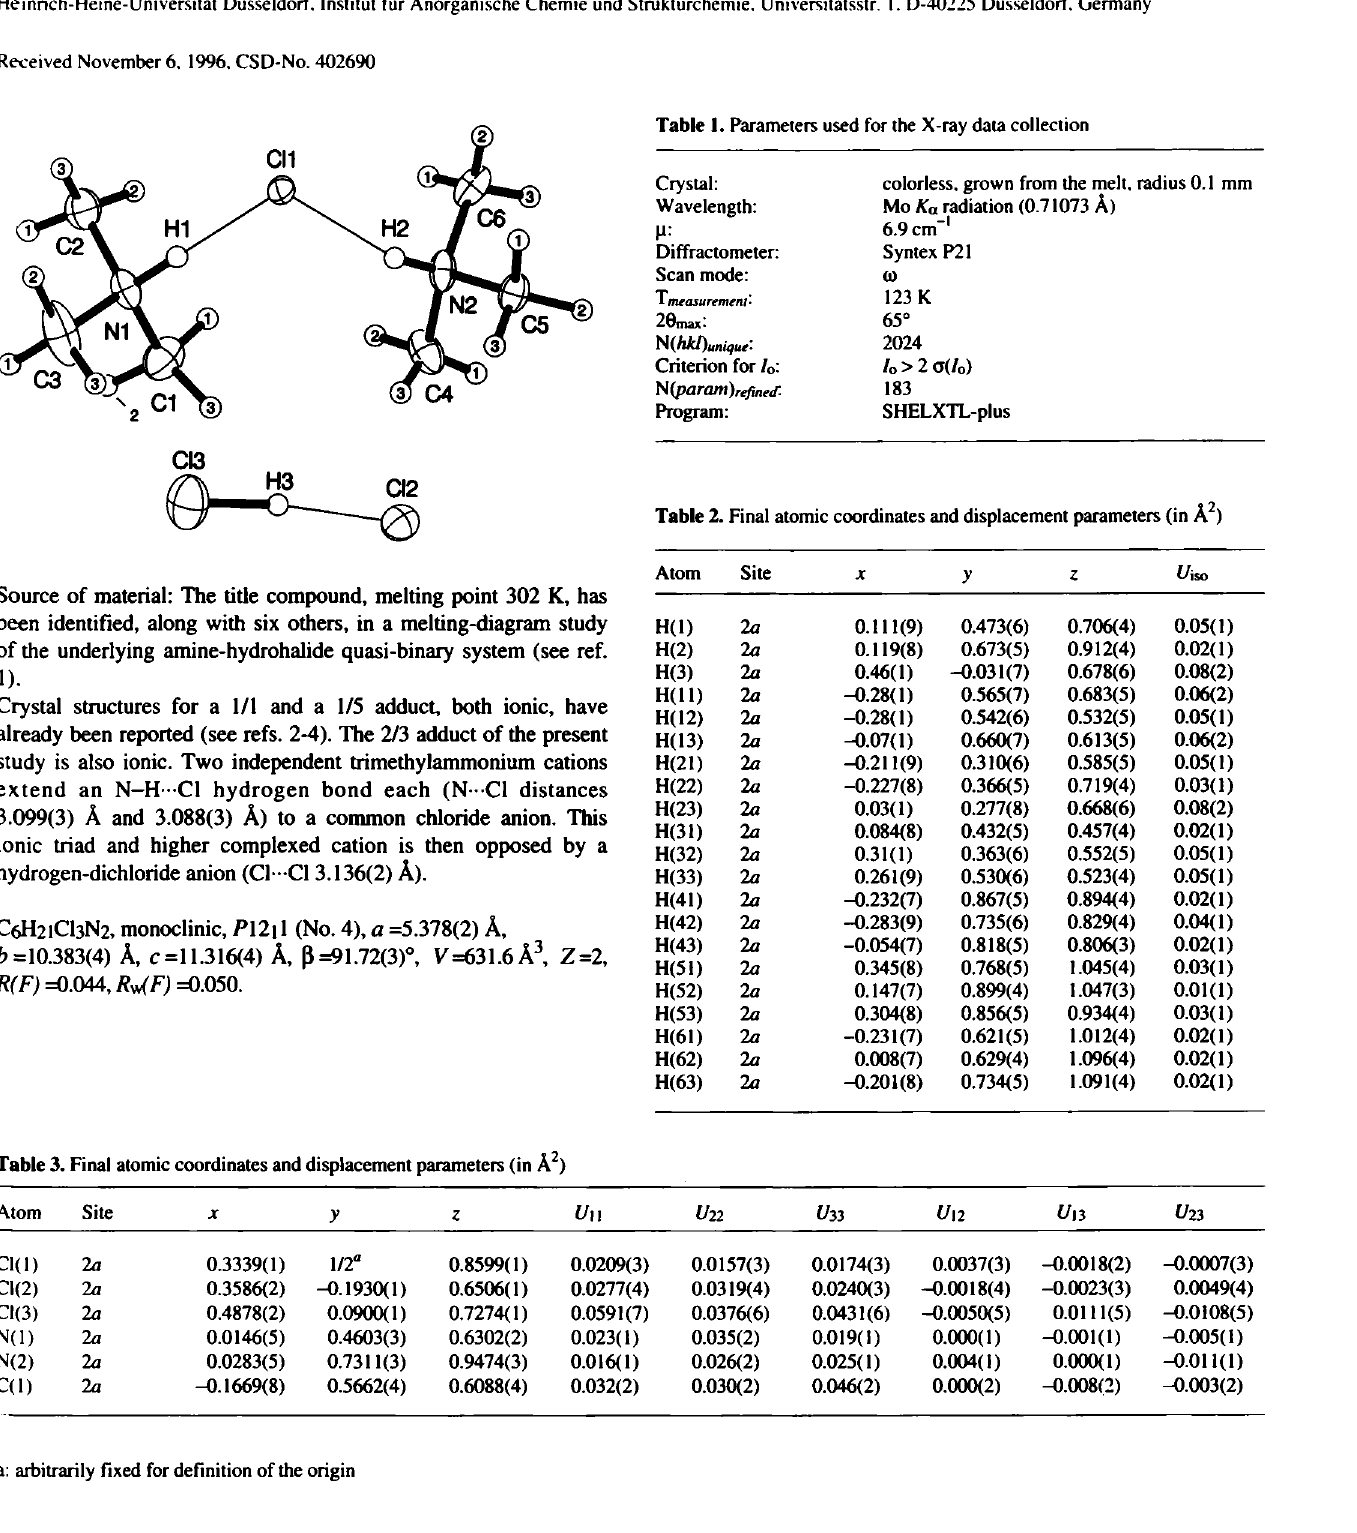
Table 3. Final atomic coordinates and displacement parameters (in Â 2